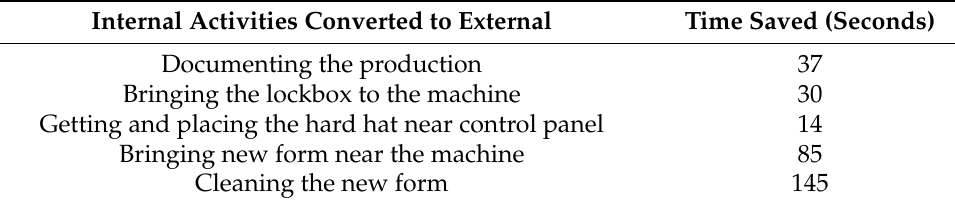
Table 1. Internal activities converted to